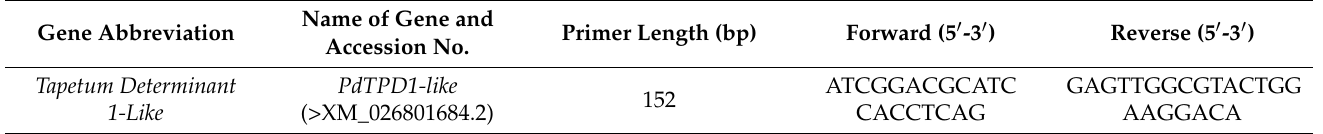
Table 1. Primer used for selected date palm suckers and unknown seedlings for PCR